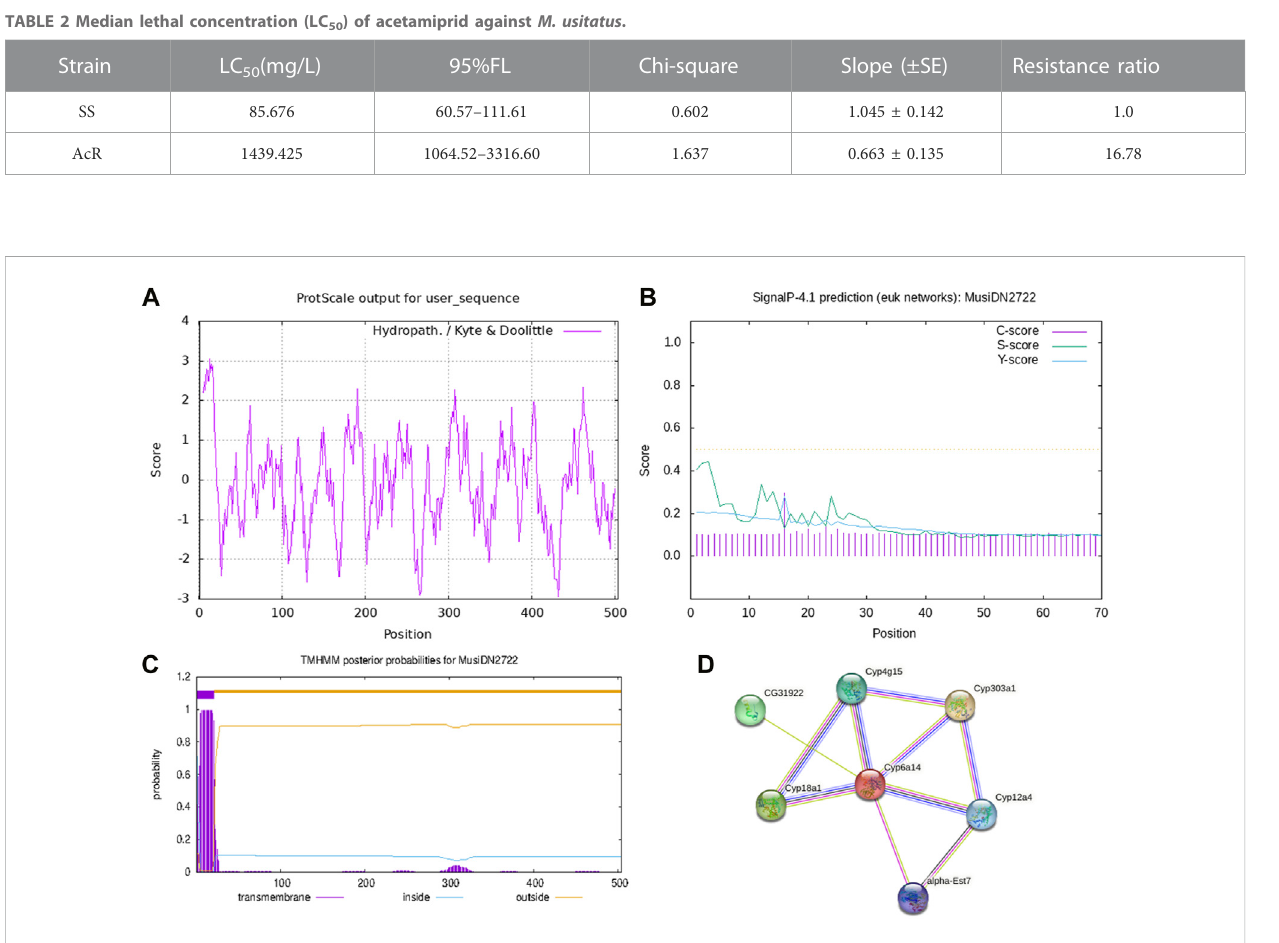
FIGURE 3 Domain analysis of MusiDN2722 . (A) Hydrophobicity analysis. (B) Signal peptide analysis. (C) Prediction of transmembrane domain structures. (D) Prediction of